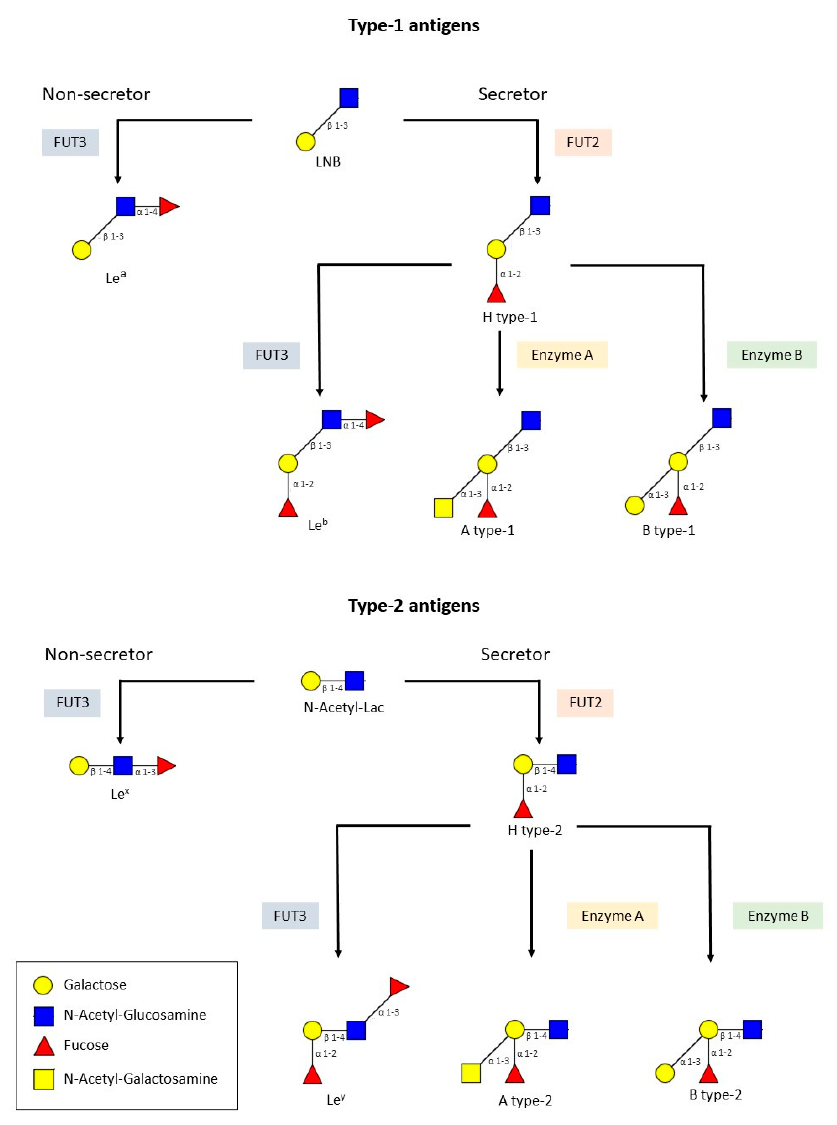
Figure 1. Biosynthesis route for type-1 and -2 HBGAs. The type-1 and the type-2 precursors are further elongated by the fucosyltransferase-2 (FUT2) that adds fucose in α -1 → 2 to the galactose moiety and the fucosyltransferase-3 (FUT3) that adds fucose in α -1 → 3/4 to N-acetyl-glucosamine to produce H and Lewis antigens, respectively. Similarly, the A and B enzymes elongate the sugar chains by attaching an N-acetyl-galactosamine or galactose in α -1 → 3 to the galactose moiety, producing the A and B blood groups, respectively.